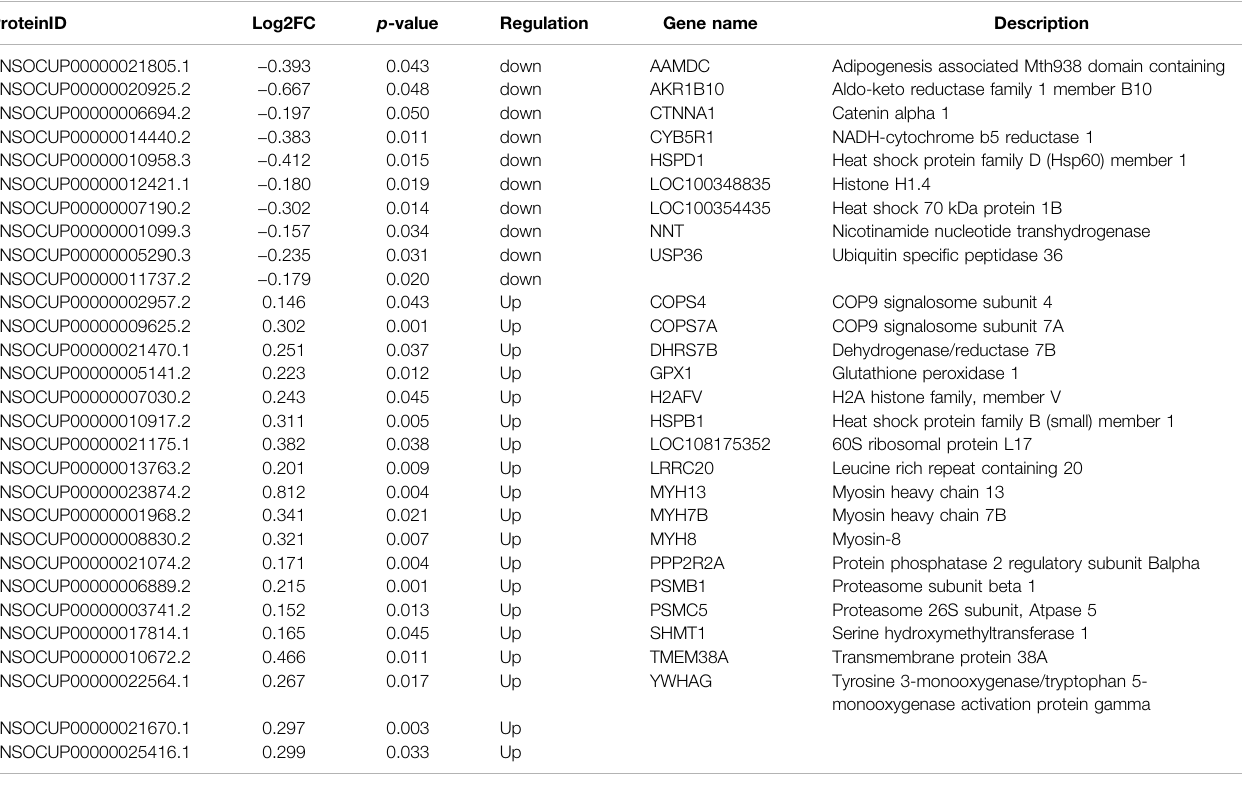
TABLE 3 | Differentially expressed proteins in the longissimus muscle tissues of SCWrabs and ZIKArabs. ProteinID